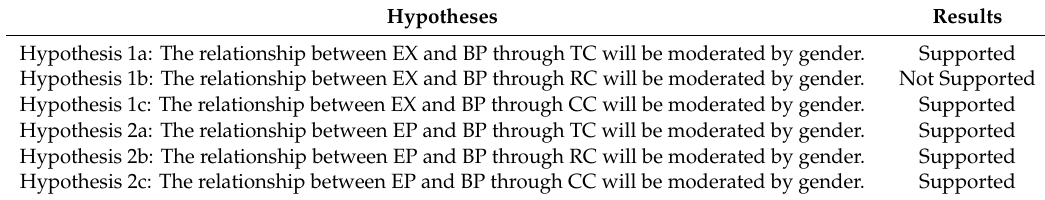
Table 6. Summary of the